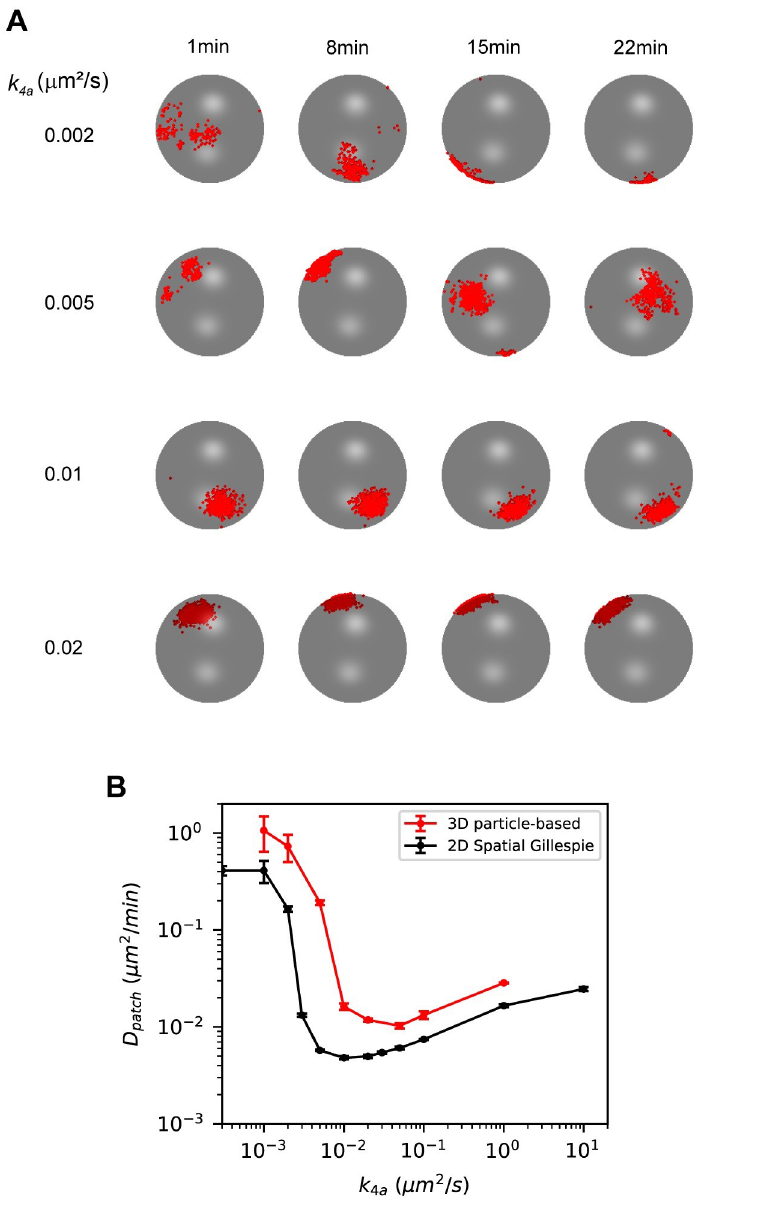
Fig 9. 3D particle-based simulations recapitulate 2D spatial Gillespie simulations results from Fig 8. (A) Snapshots of 3D particle-based simulations for different values of k 4a . Cdc42T molecules are shown as red dots on a spherical surface representing the cell membrane. Rate constants are estimated from the ones used in Fig 8B as described in the Methods. Parameters are presented in Table 1. (B) Patch centroid diffusivity as a function of k 4a for 3D particle-based simulations (red) with GEF = 100. For comparison we also show results from 2D spatial Gillespie simulations in Fig 8. Error bars are standard errors from the least-squared fit used to compute D patch .